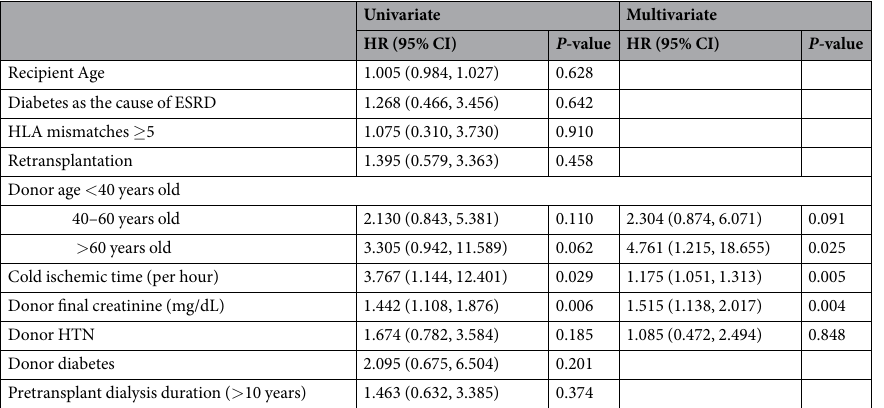
Table 5. Risk factor analysis for incompletely recovered DGF. DGF = delayed graft function, ESRD = end stage renal disease, HTN = hypertension.